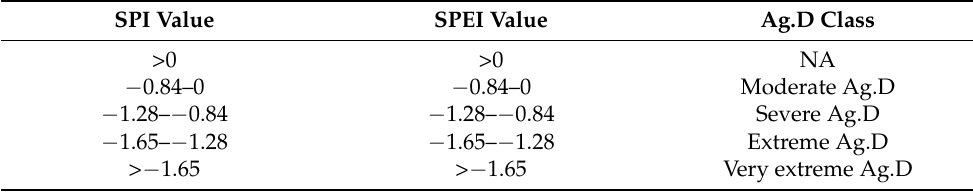
1990 and 2019 (right between 1990 and 2019 (left graph); ( b ) production in tons across Hungary (middle graph); and ( c ) sunflower yield be-